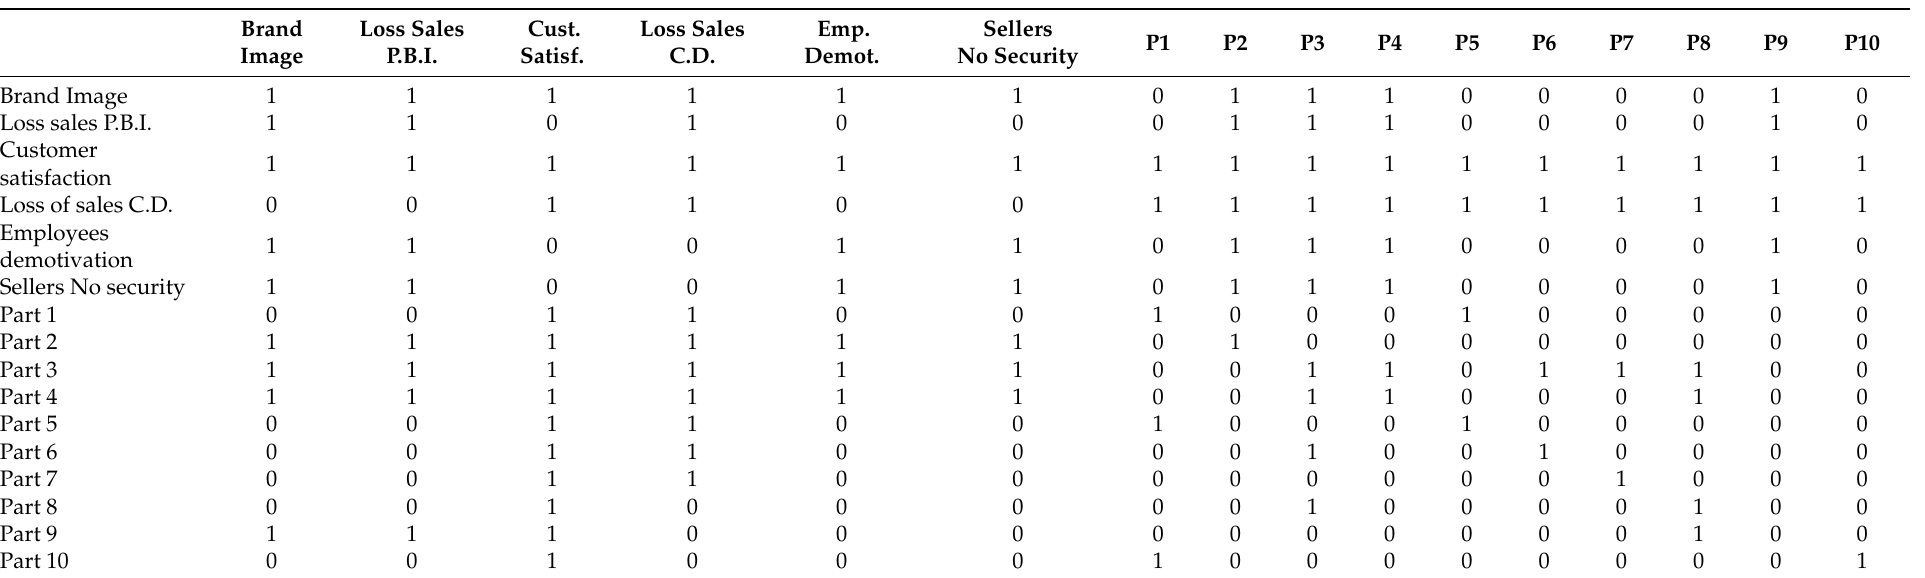
Table 7. Interfactorial dominance